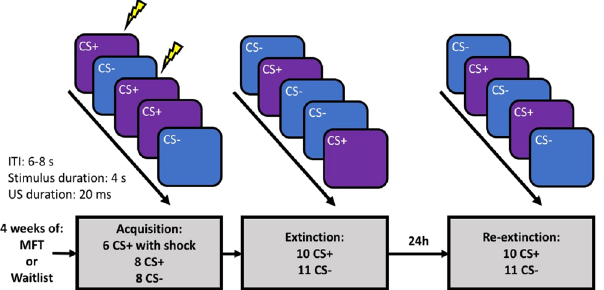
Figure 1. Experimental design: Subjects were randomized to either 4-weeks of daily MFT or a waitlist condition and subsequently completed a 2-day fear and extinction learning protocol. During acquisition, two neutral cues (a blue or purple square) were repeatedly presented on a computer screen, and one of the cues (CS + ) was paired with an aversive electrical shock (US) with a reinforcement rate of 43%, whereas the other cue (CS − ) was never paired with a shock. Acquisition always began with a reinforced CS + presentation and subsequent stimulus presentations were pseudorandomized, so that none of the stimuli appeared more than two times consecutively. Then the subjects underwent immediate extinction where the CS + and CS −